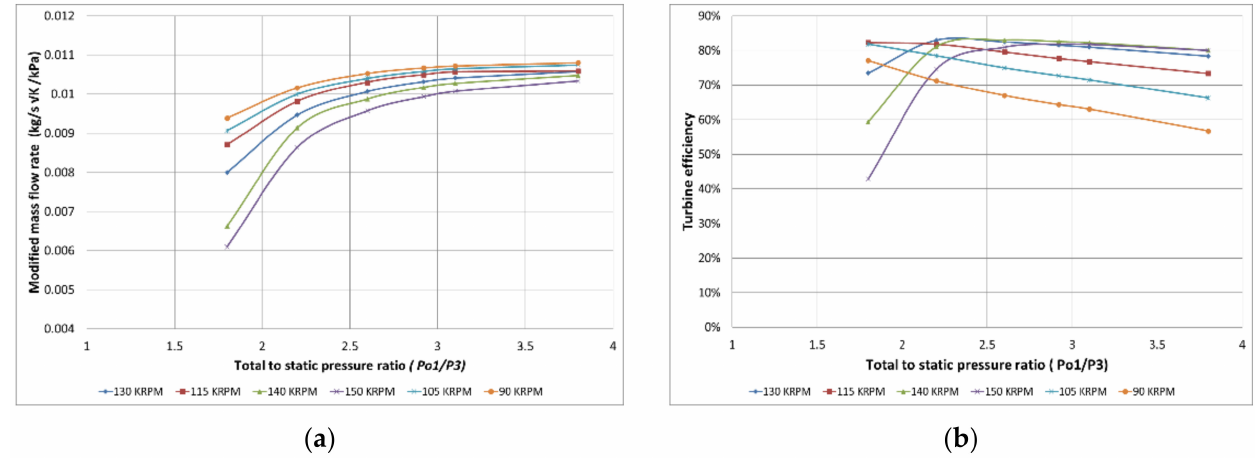
Figure 5. ( a ) Turbine performance map; ( b ) Turbine efficiency versus pressure ratio [29].